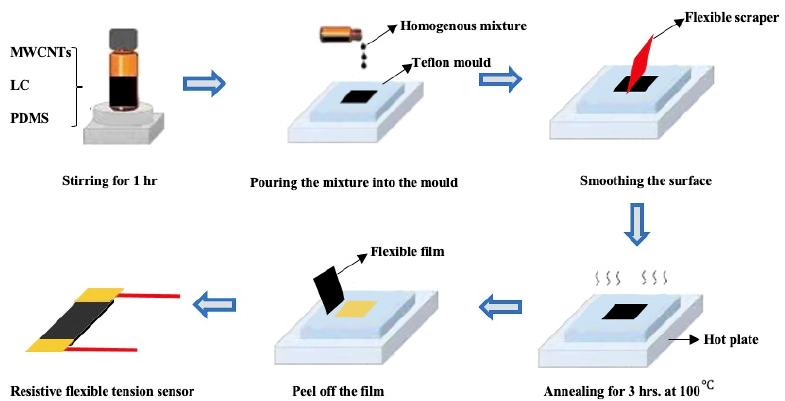
Figure 3. The fabrication process of the flexible resistive sensor.